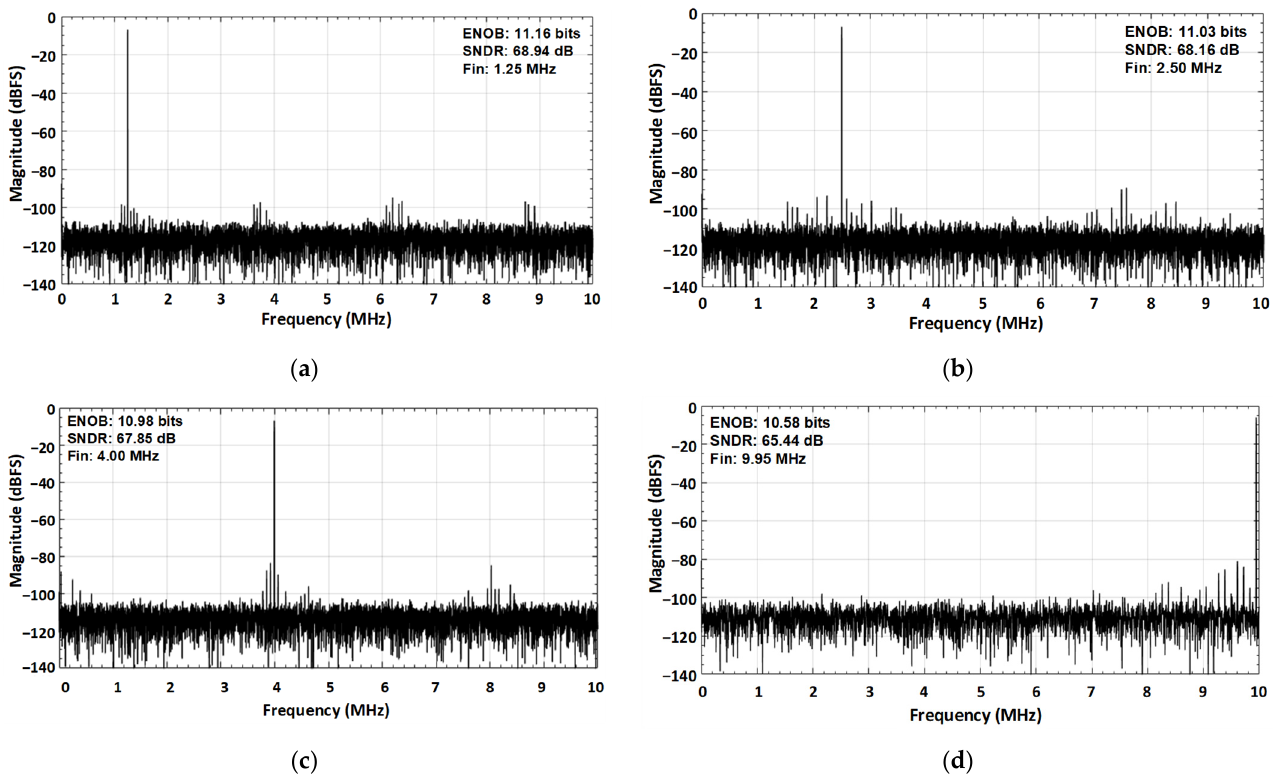
Figure 13. Measured dynamic performance for two different input frequencies at the sampling rate of 20 MS/s ( a ) for 1.25 MHz input frequency ( b ) for 2.50 MHz input frequency ( c ) for 4.00 MHz input frequency, and ( d ) for nyquist input frequency of 9.95 MHz.